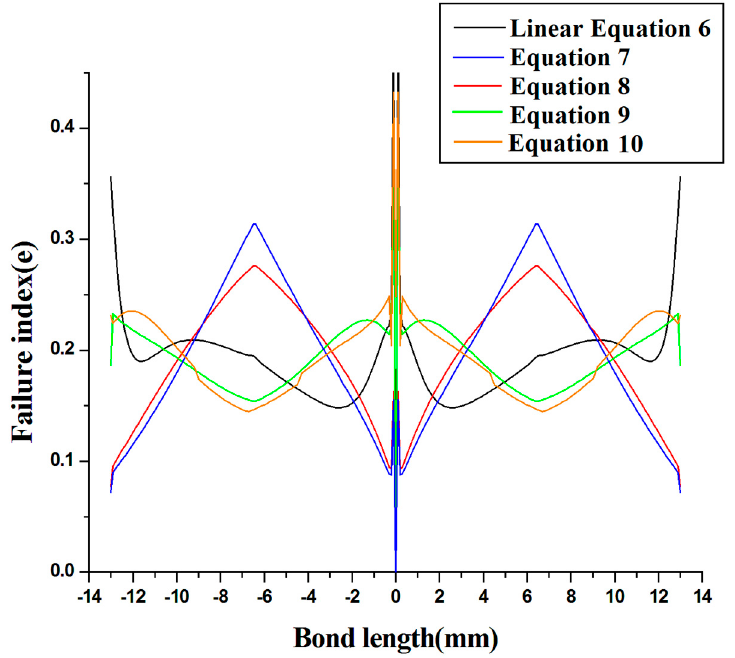
Figure 8. Failure indexes of various even power law profiles compared to linear profiles.